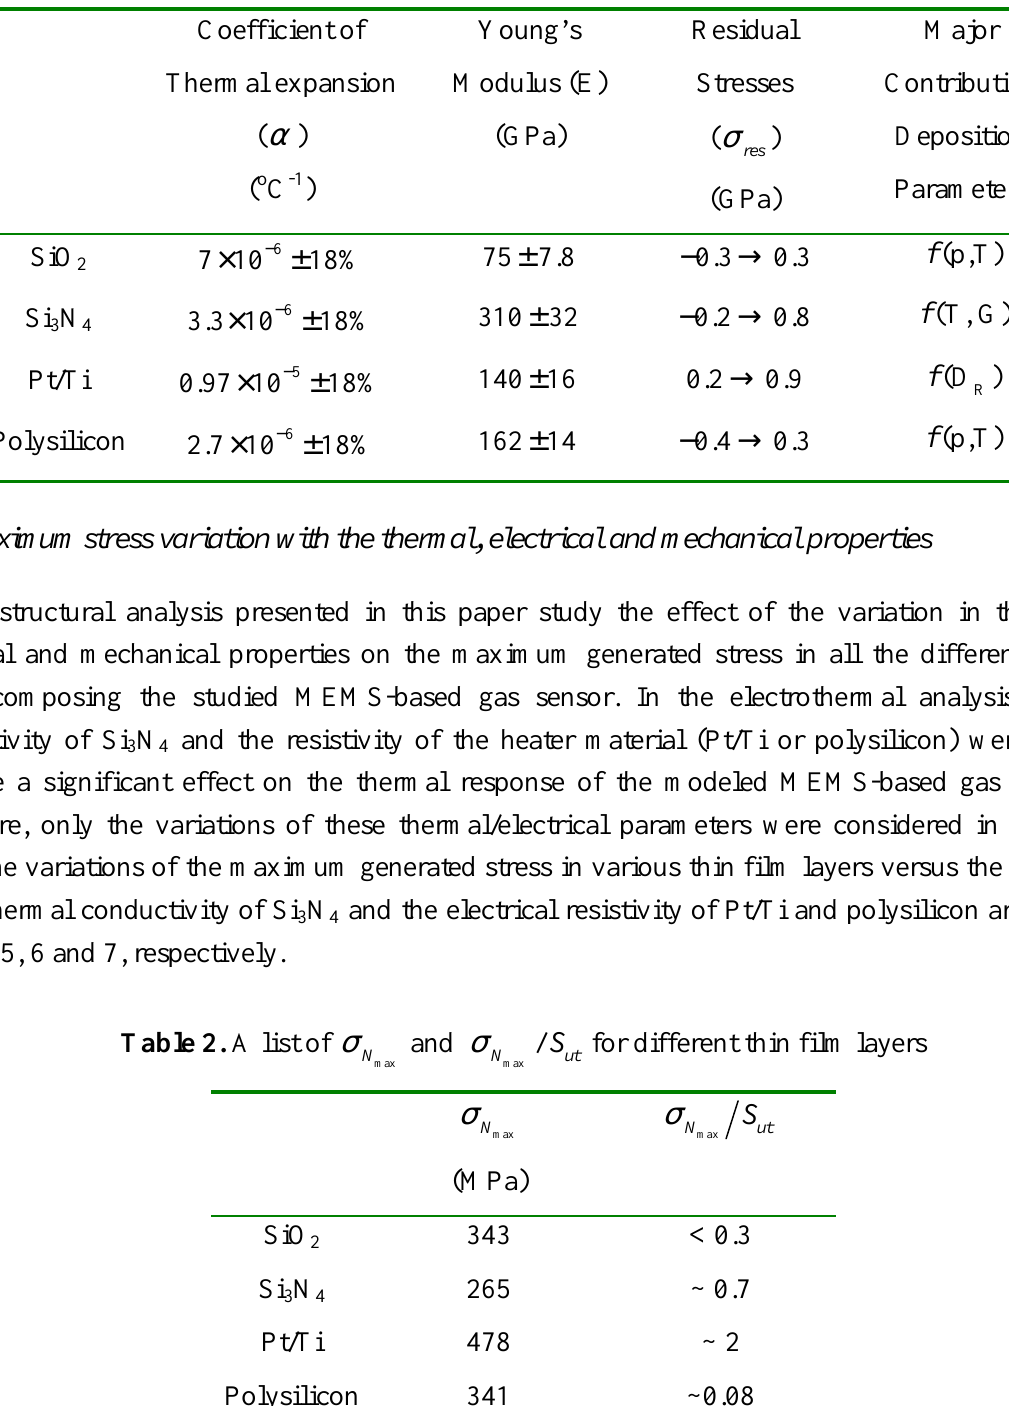
Table 1. A list of the studied parameters and their reported variations, [15, 16-20, 34,